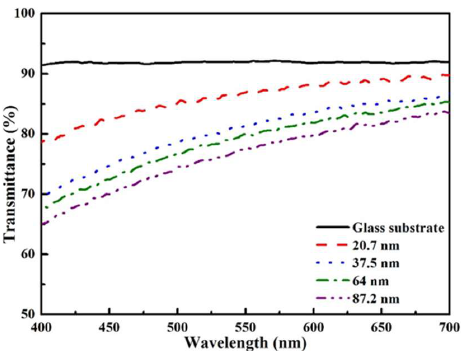
Figure 9. The transmittance spectra of SiO x :DLC films with different thickness. (RF bias = 400 V, DC power = 50 W, CH 4 = 12.5 sccm, HMDSO = 0.9 sccm)